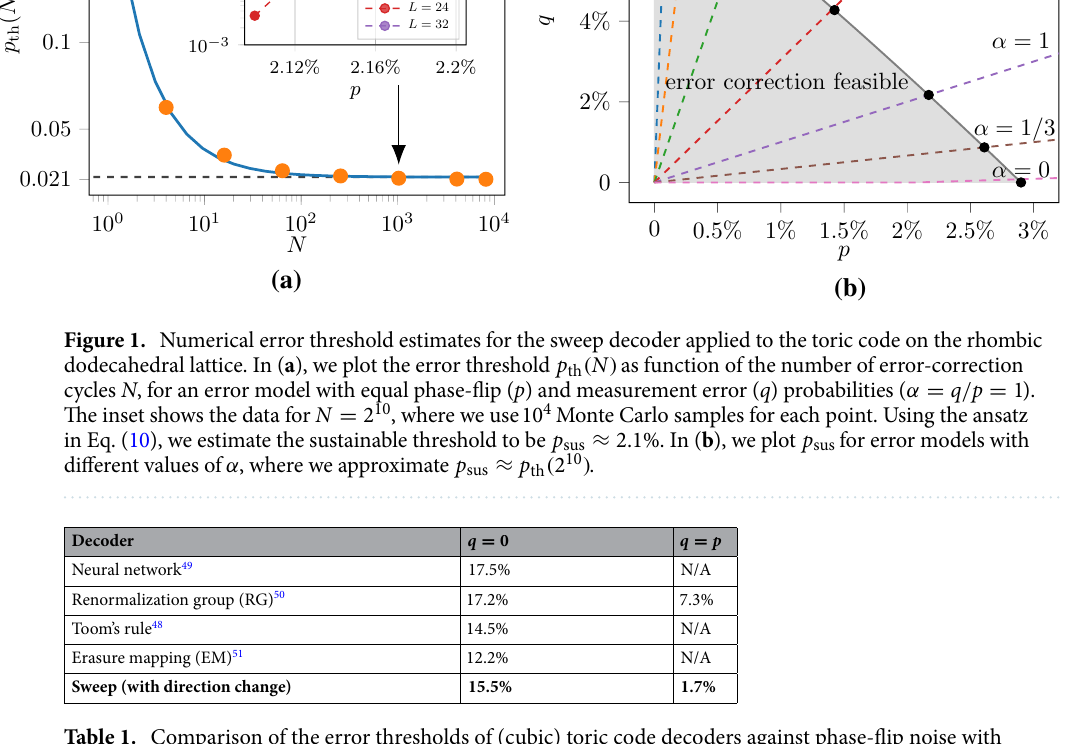
Fig. 1. We note that the sweep rule decoder cannot be used to decode bit-flip errors in the 3D toric code, as their (point-like) syndromes do not have the necessary structure. However, 2D toric code decoders can be used for this purpose, e.g. 10,42–47 .